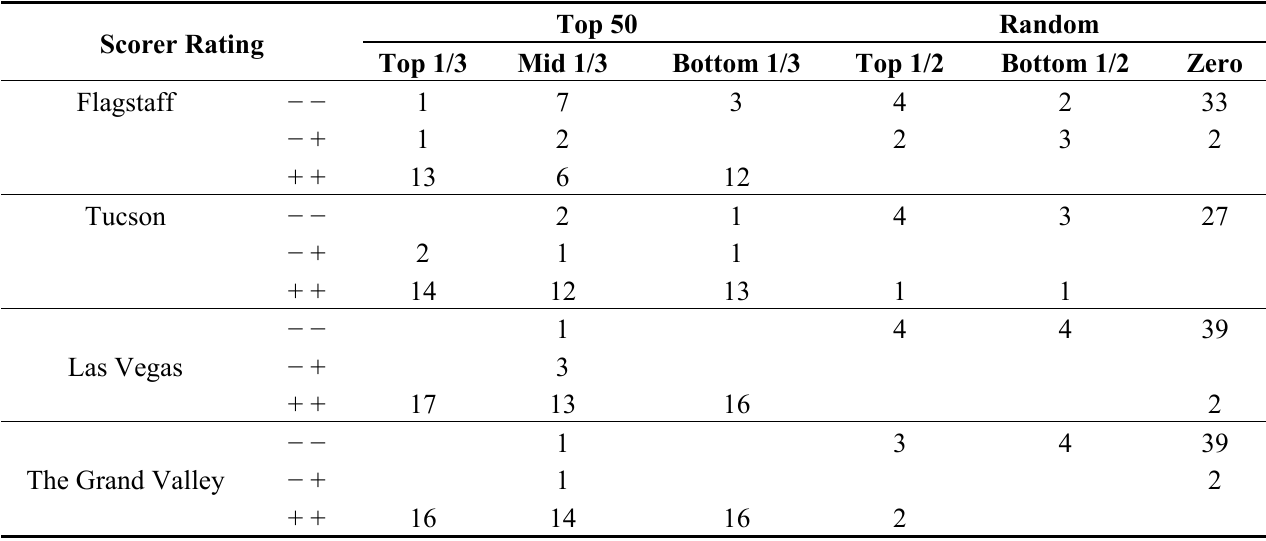
Table 4. Validation results for article relevance